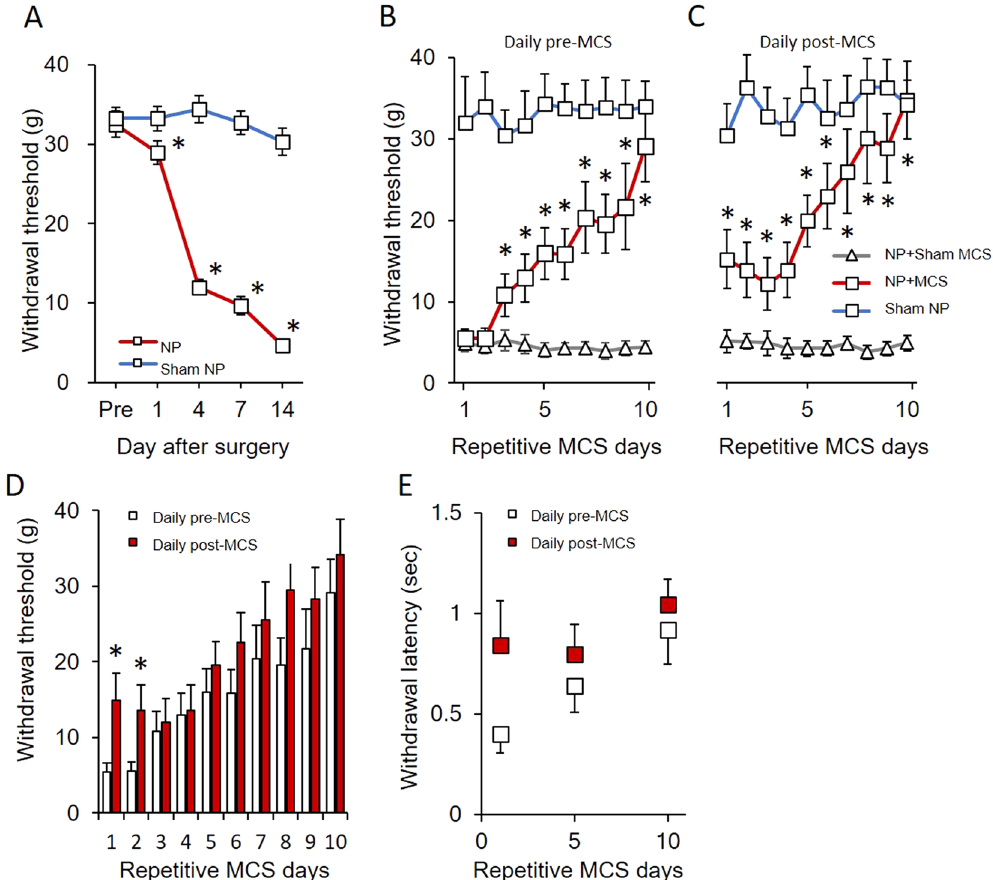
Figure 1. MCS effects on neuropathic pain. ( A ) Development of mechanical allodynia after nerve injury. On days 1, 4, 7, and 14 after surgery, neuropathic rats showed a significantly decreased mechanical withdrawal threshold compared with the sham-operated group ( B ) Comparison of the daily pre-MCS behavioral tests. The mechanical threshold changes between groups were compared with the daily pre-MCS session. From the second MCS, the withdrawal threshold gradually increased until the last day of MCS. ( C ) Comparison of the daily post-MCS behavioral tests. The mechanical threshold changes between groups were compared with the daily post-MCS session. The withdrawal thresholds were immediately elevated after MCS and gently increased. ( D ) Comparison of the withdrawal threshold changes at daily pre/post-MCS in neuropathic pain. After MCS, the mechanical threshold became insensitive and the thresholds increased with daily MCS. When comparing the daily pre/post-MCS, the thresholds of the post-MCS were higher than the pre-MCS. ( E ) Comparison of the withdrawal latency changes according to repetitive MCS. The latency was immediately elevated after MCS and gradually increased after repetitive MCS (Daily pre-MCS: ρ value = 0.753, P = 0.03; Daily post-MCS: ρ value = 0.28, P = 0.13). * P < 0.05 compared with NP + sham